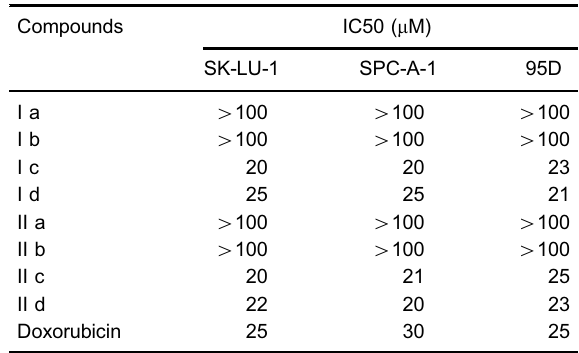
Table 3. In vitro anti-proliferative activity of I (a – d) and II (a – d) against human cancer cell lines.